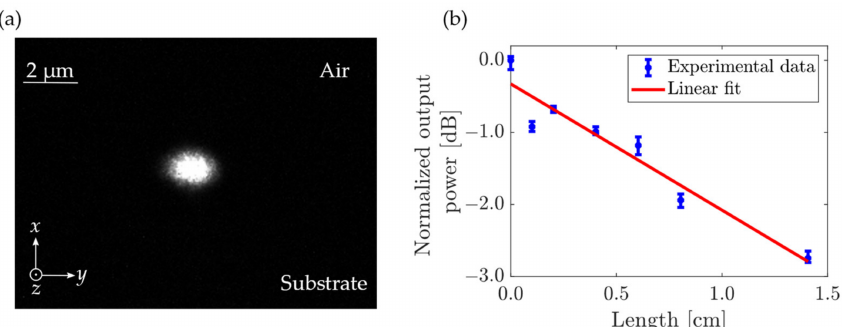
Figure 9. ( a ) Photograph of the output quasi-TM fundamental mode at the output of waveguide (chip 2) with bend radius of 5 µ m. ( b ) Normalized power measured at the output of the waveguides (chip 1) as a function of the length of the waveguide (blue circles) and a linear fit (red line) using the cut-back method. Propagation losses are estimated at 1.75 ± 0.32